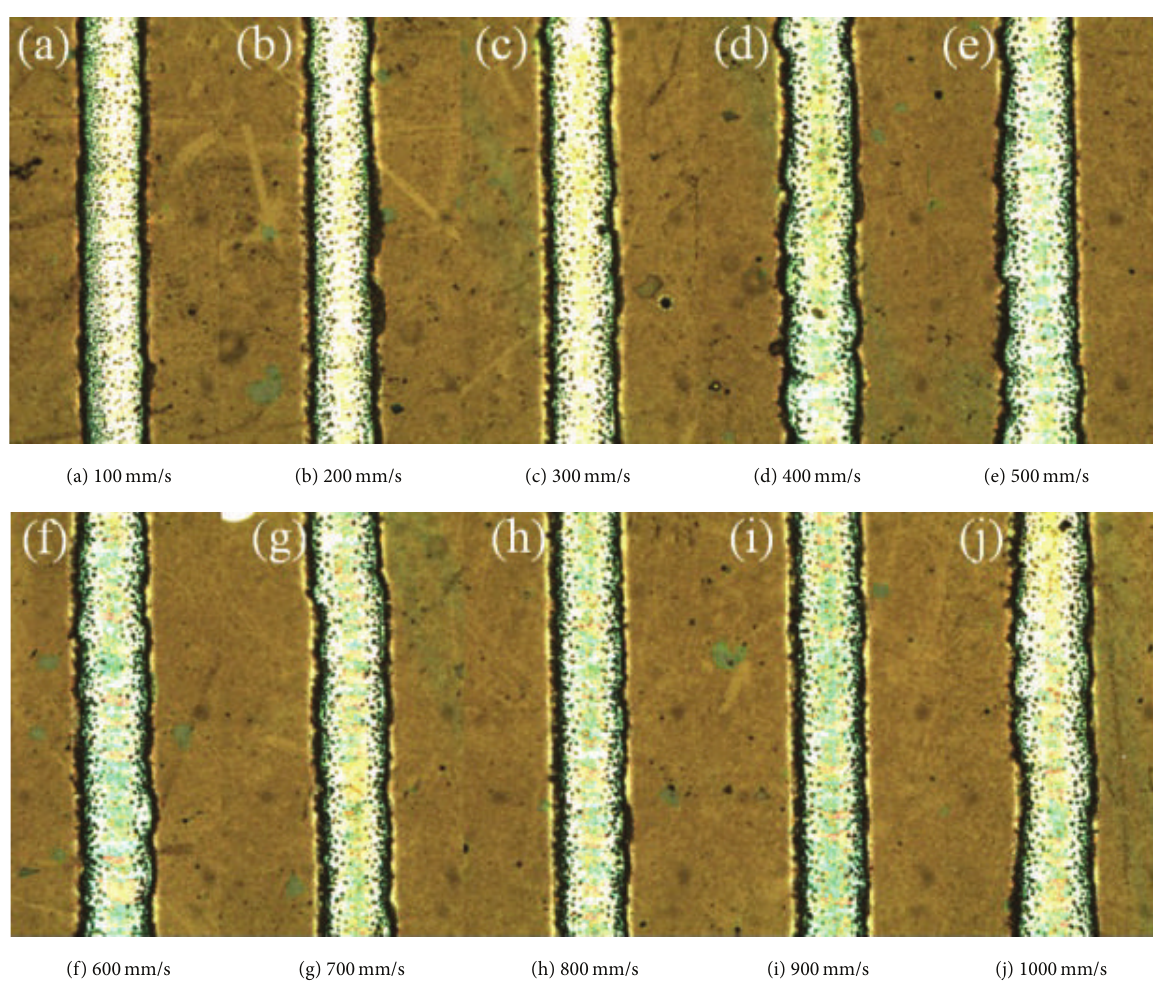
Figure 6: UV laser scribing P2 layer at different scan